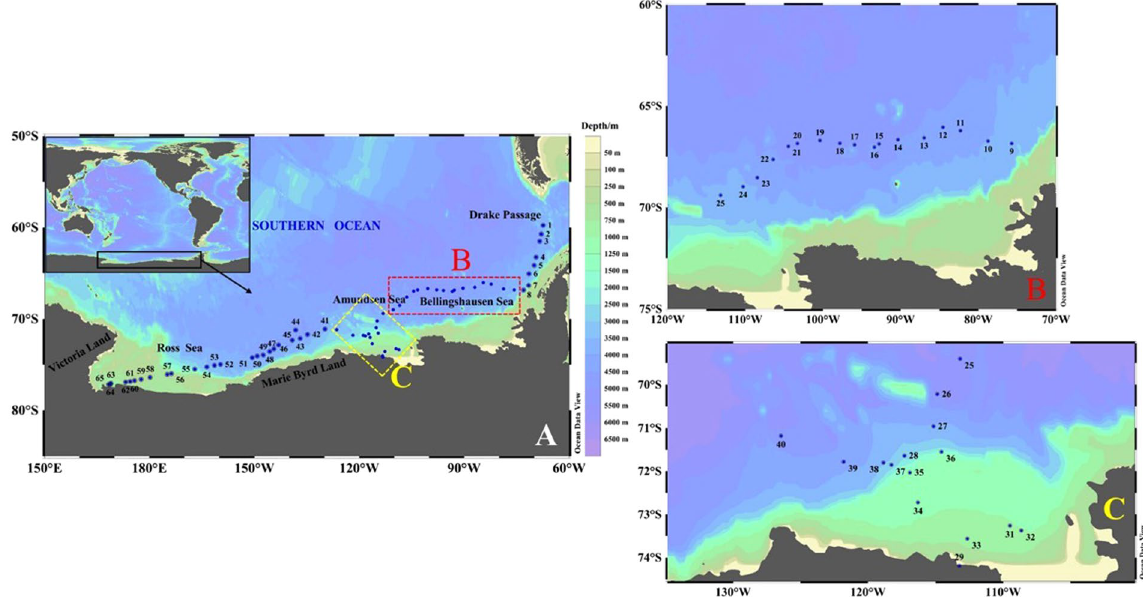
Figure 5. Sampling transect along the Antarctic coast, sampling locations are shown as blue dots. Details of sampling locations of surface seawater in the Bellingshausen Sea ( B ) and in the Amundsen Sea ( C ) are shown in figures 5B and 5C. The original map was constructed by a free software Ocean Date View (ODV 4.7.8) (Schlitzer, R., Ocean Data View, odv.awi.de,